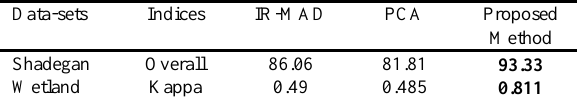
Table 2. Performance of the proposed method and other conventional CD methods for all data